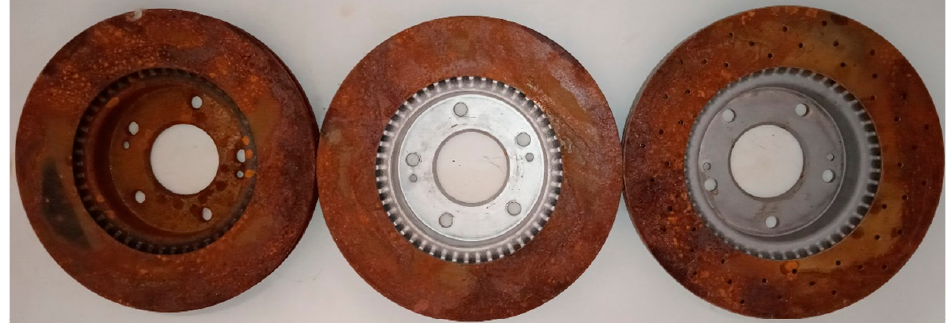
Figure 18. Corrosion on the inner side of brake discs.